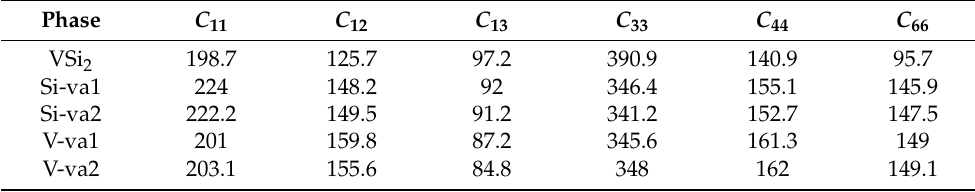
Table 2. The elastic constants C ij (GPa) of C11 b -VSi 2 with various vacancies. Phase C 11